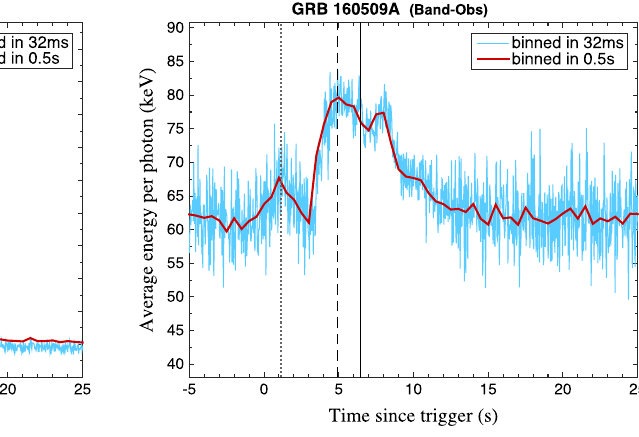
refer to t obs /( 1 + z ) of Criterion 2 (the significant peak of the average energy curve). The dotted lines refer to a smaller peak in the light